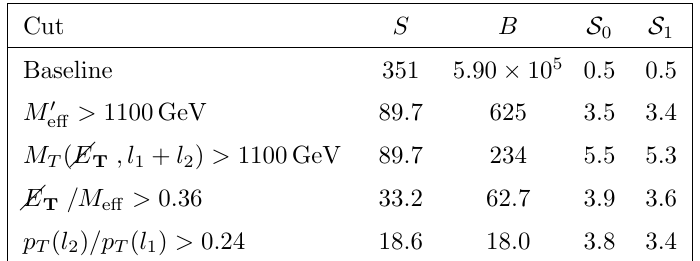
Table 6 . Cuts made for distinguishing signal and background at FCC with a luminosity of 3 ab (cid:0) 1 . We show the number of signal and background events for m N employed (cid:21) 3 = 0 : 27 in the analysis. No systematic errors on the background were assumed for (cid:0) this